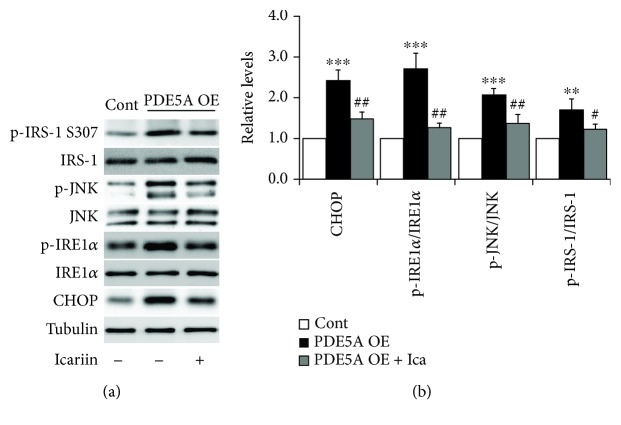
Effects of PDE5 inhibitor icariin (Ica) on ER stress in PDE5A-overexpressed C2C12 myotubes. (a) Representative western blots showing the effects of icariin on the ER stress markers and phosphorylation of JNK and IRS-1 S307; (b) quantification of the protein or phosphorylated protein levels in (a). N = 4. ∗∗P < 0.01, ∗∗∗P < 0.001 vs. the control group; #P < 0.05, ##P < 0.01 vs. the PDE5A-overexpression (OE) group.